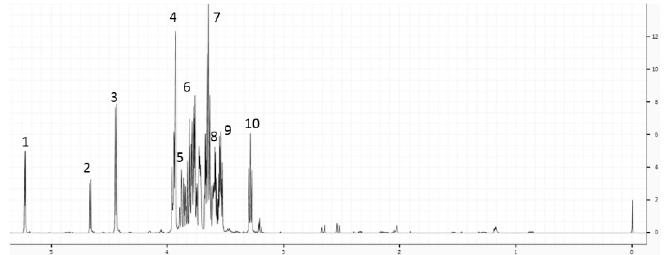
Figure 1. A representative 1 H nuclear magnetic resonance (NMR) spectrum of human milk. The 1 H chemical shifts for lactose are annotated 1 to 10.